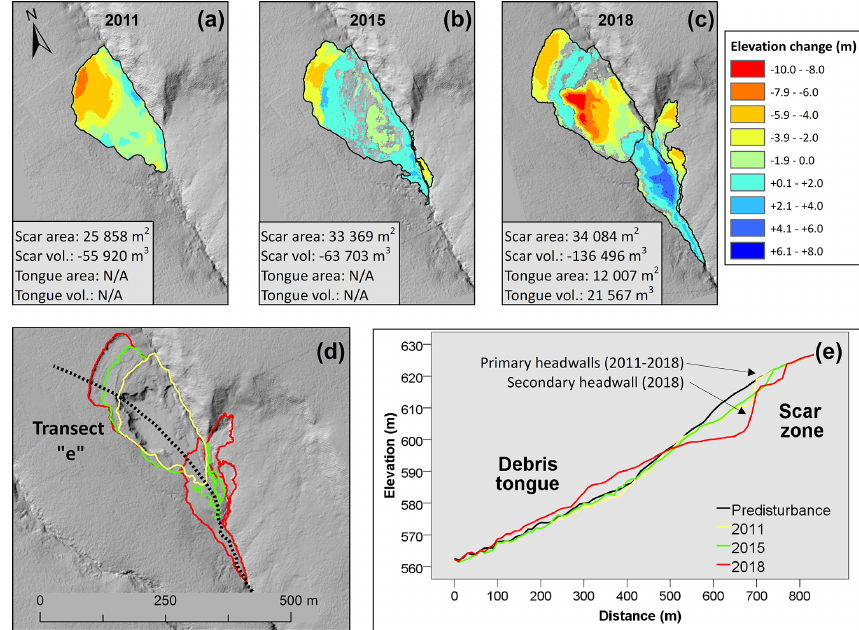
Figure 3. Retrogressive thaw slump growth (slump CB), material displacement, and evolution of downstream connectivity from 2011 to 2018 on Peel Plateau, Northwest Territories, Canada. (a) 2011 difference from the reconstructed pre-disturbance terrain surface. (b) 2015 terrain differenced from the 2011 terrain. (c) 2018 terrain differenced from the 2015 terrain, showing polycyclic behavior including thaw-driven evacuation of scar materials and development of a prominent lower “secondary” headwall and scar concavity. Thaw slump and debris tongue area and volumes are calculated relative to estimated pre-disturbance surface. (d) The evolution of the thaw slump footprint from 2011 to 2018 and the topographic transect in (e) showing elevation profiles through the slump and along the valley for pre-disturbed terrain in 2011, 2015, and 2018. The hillshade in (d) is the 2018 UAV survey integrated with the surrounding 2011 regional lidar